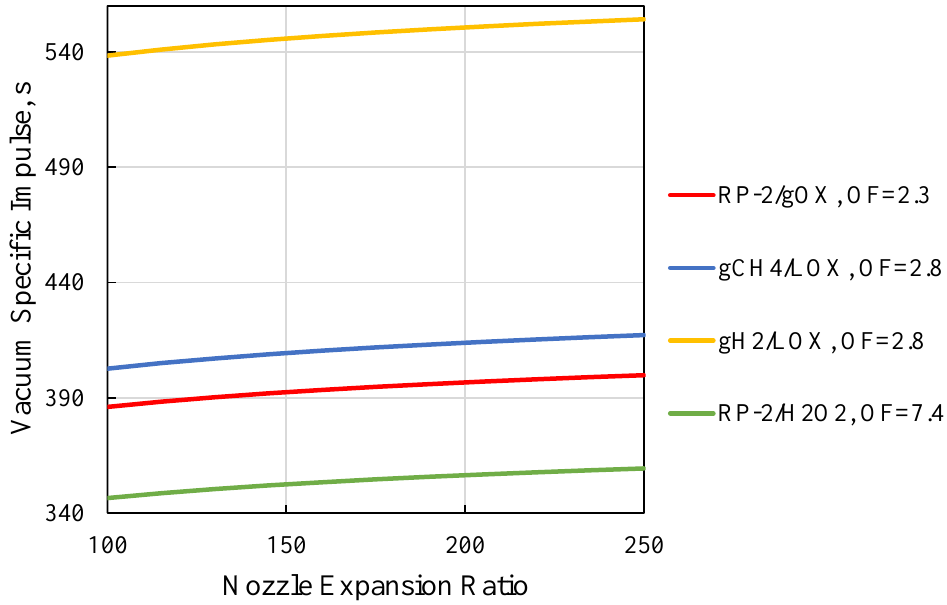
Figure 4. Theoretical RDRE performance variation with nozzle expansion ratio at 10 atm chamber pressure using the Stechmann et al. [22] performance model for the propellant combinations noted in Table 1.